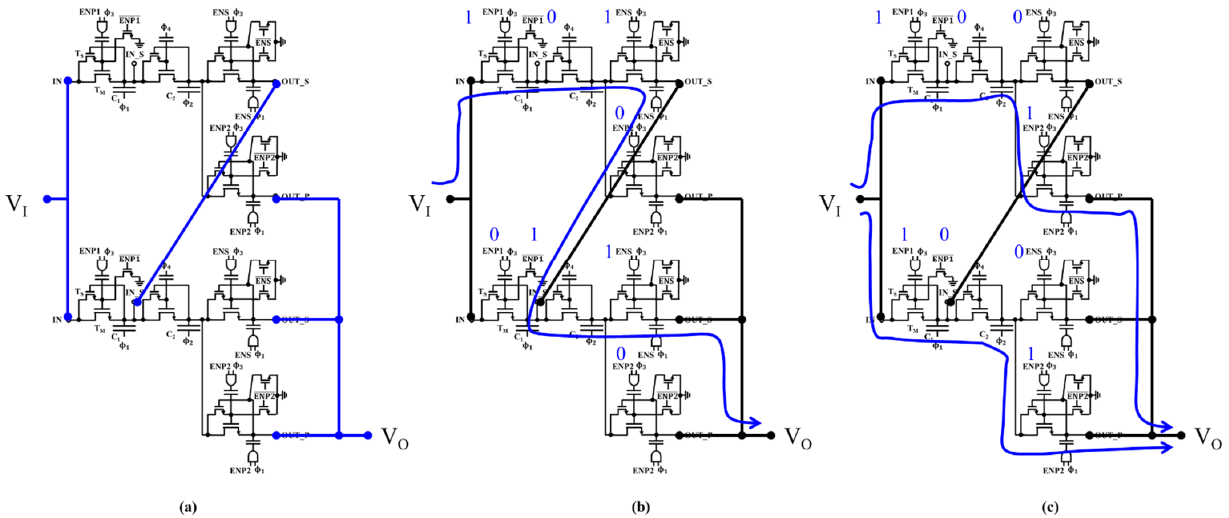
Figure 5. ( a ) Reconfigurable CP with two two-stage units; ( b ) operation of the CP with two two-stage units connected in series; ( c ) operation of the CP with two two-stage units connected in parallel.